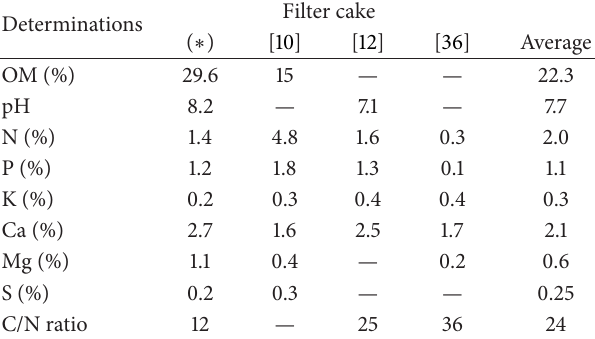
Table 2: Concentrations of organic matter (OM) and mineral elements, pH values, and C/N ratios determined in filter cake calculated on dry weight basis. Data are taken from reports of different authors for contrasting pedoclimatic